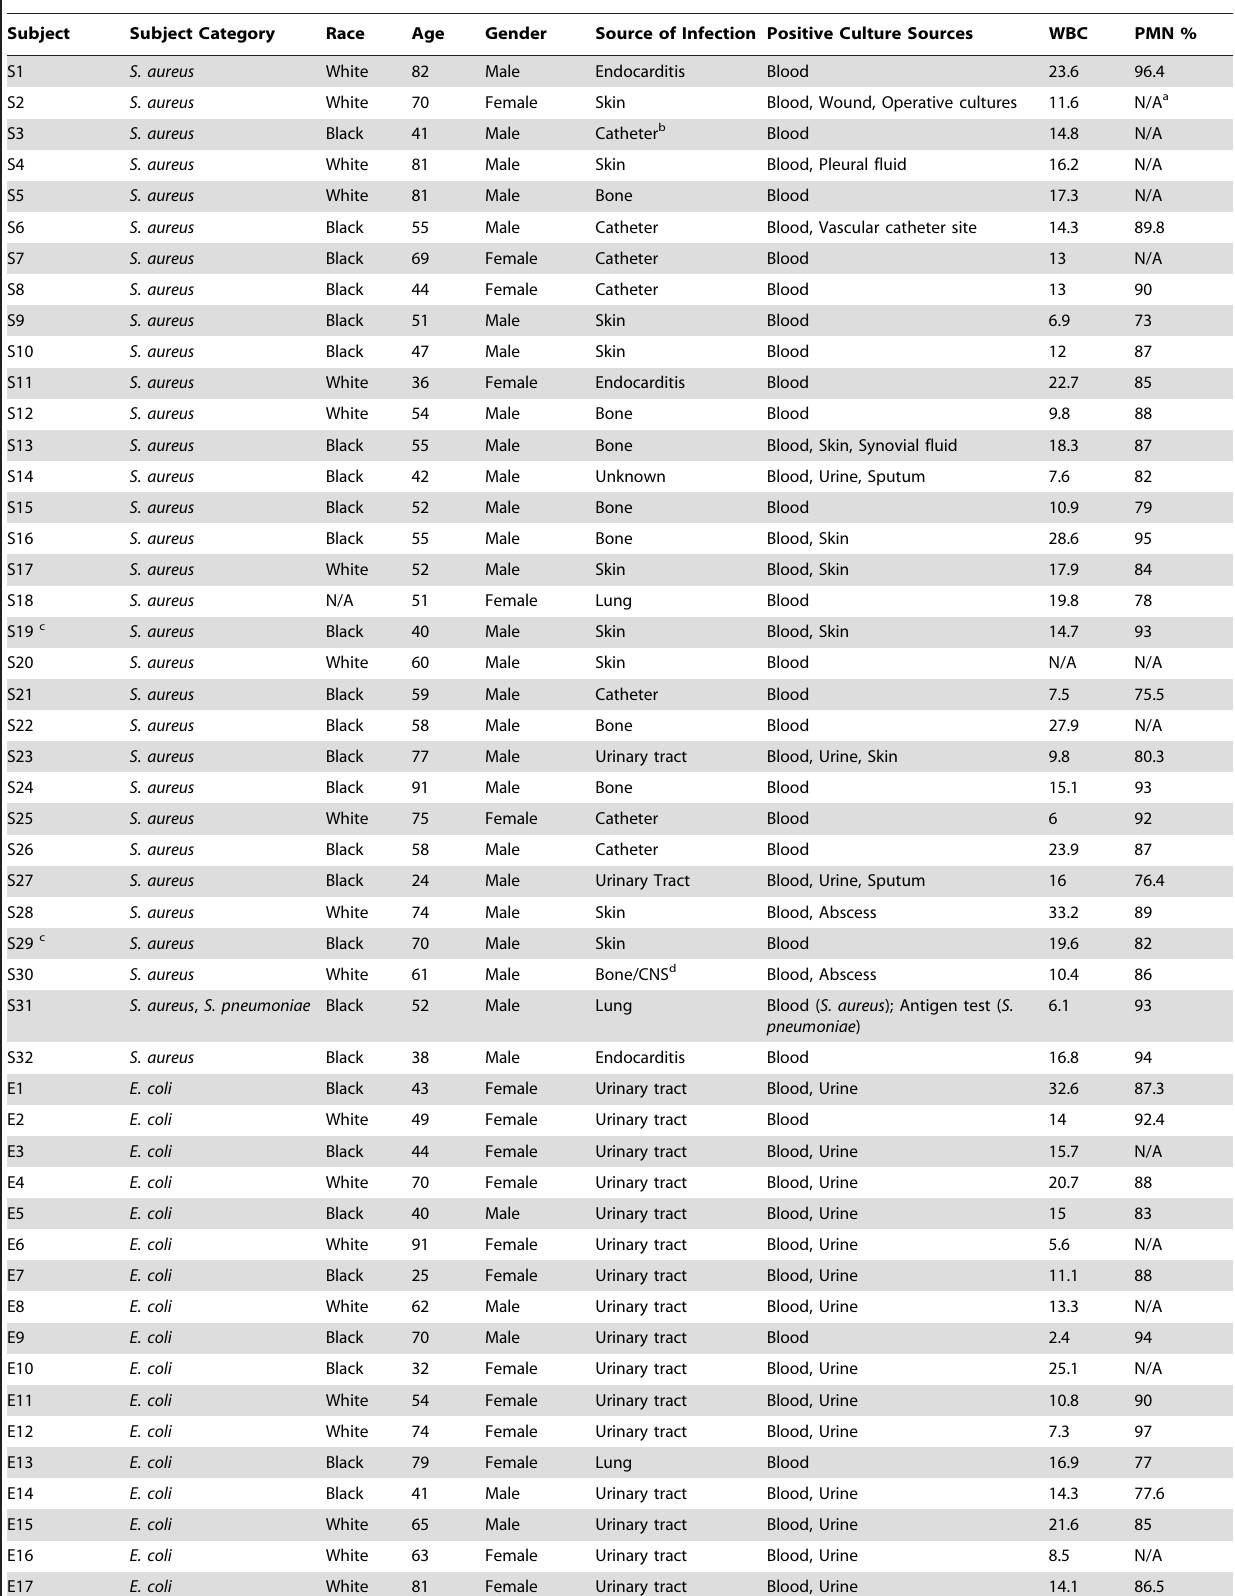
Table 1. Description of human subjects used to generate a S. aureus